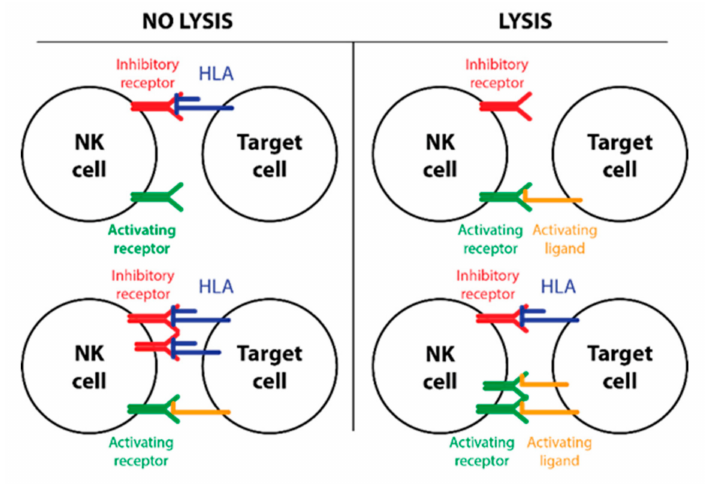
Figure 1. The regulation of natural killer (NK) cell activity is based on the balance between activating and inhibitory signals. NK cells are muted in cases of the absence of an activating signal or stronger inhibitory signals compared with activating ones. The NK cells are fully activated and kill the target cell when the ligand for inhibitory signals is missing or when the activating signals exceed inhibitory